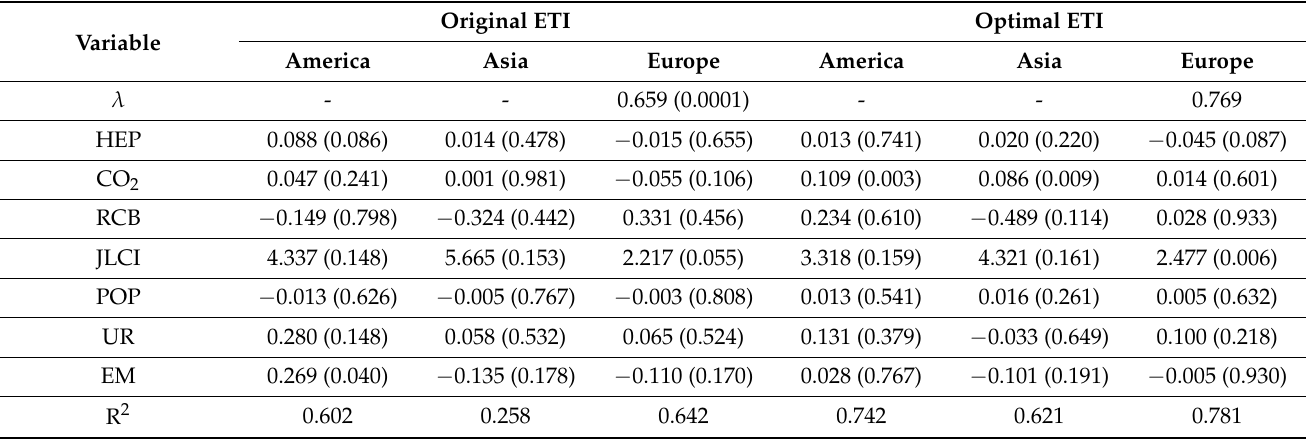
Table 5. Estimation results for ETI (new and optimised) for different